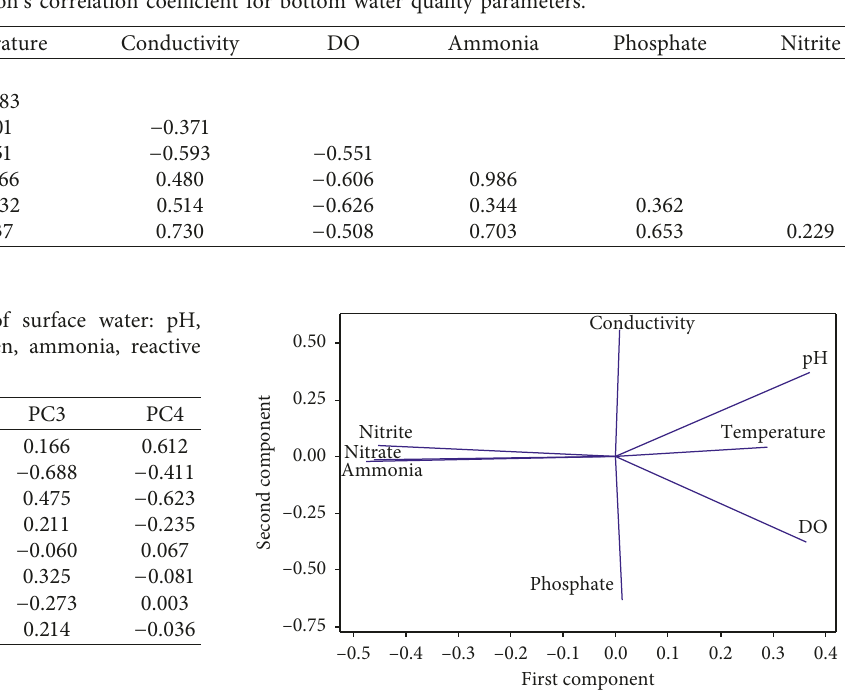
Figure 6: Component loadings for the first component and the second component for surface water. Table 4: Principal component analysis of bottom water: pH, temperature, conductivity, dissolved oxygen, ammonia,